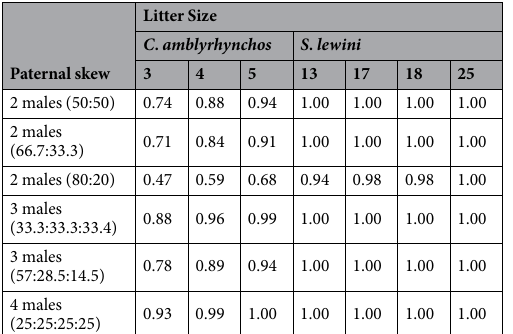
Table 3. Probability to detect multiple males (PrDM) using different suites of microsatellite markers: 14 loci for C. amblyrhynchos and 10 loci for S. lewini under a number of paternal skew